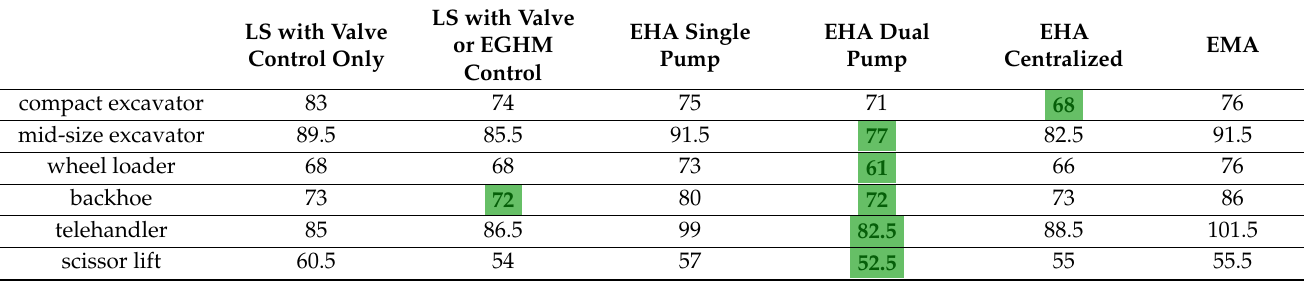
Table 2. Mismatch values for all 36 actuator-HDMM matches and weight matrix W = W 0 . The best values for each HDMM type have been marked